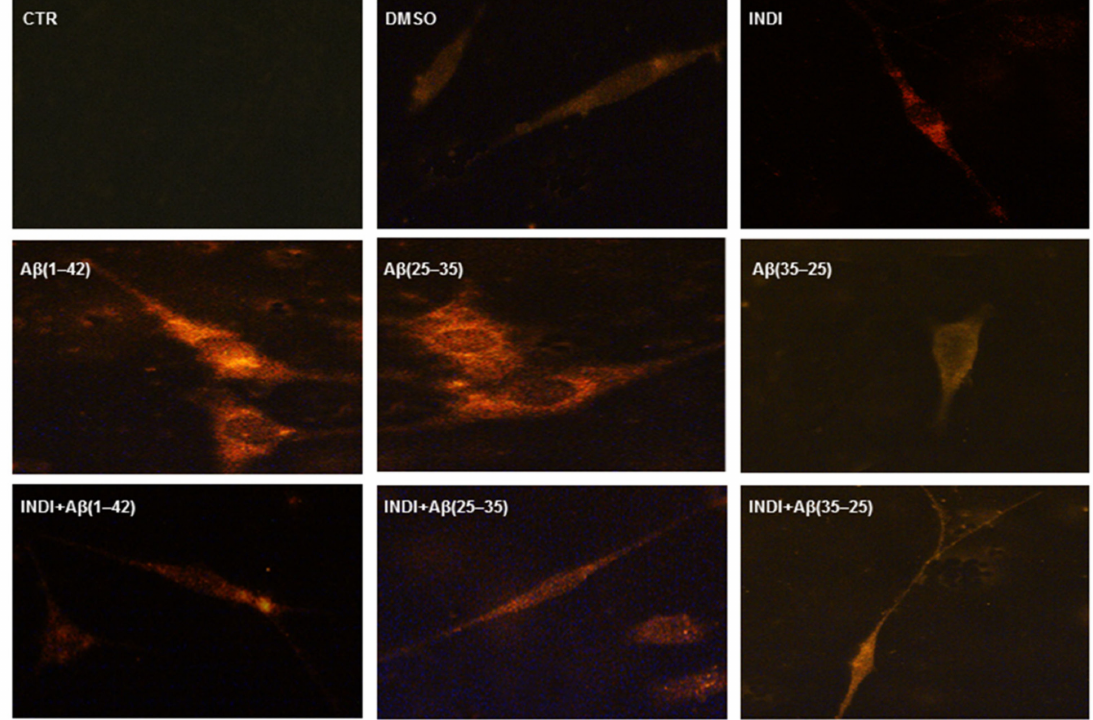
Figure 8. Immunocytochemistry for anti-caspase-3 in OECs. Images show different conditions: control, DMSO, 100 µ M indicaxanthin (INDI), 10 µ M A β (1-42) or A β (25-35) or A β (35-25) both in the absence and presence of 100 µ M INDI for 24 h. Scale bar 20 µ